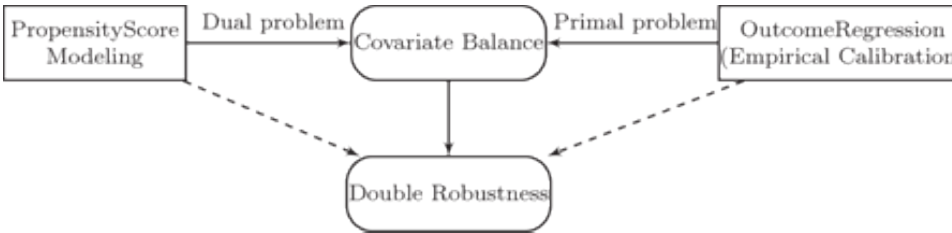
Figure 1: The role of covariate balance in doubly robust estimation. Dashed arrows: conventional procedure to achieve double robustness. Solid arrows: double robustness of Entropy Balancing via covariate